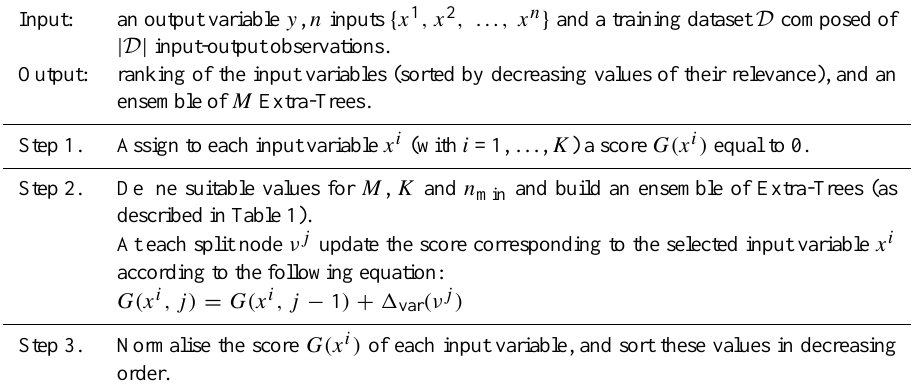
Table 2. Tabular version of the Extra-Trees input ranking algorithm.